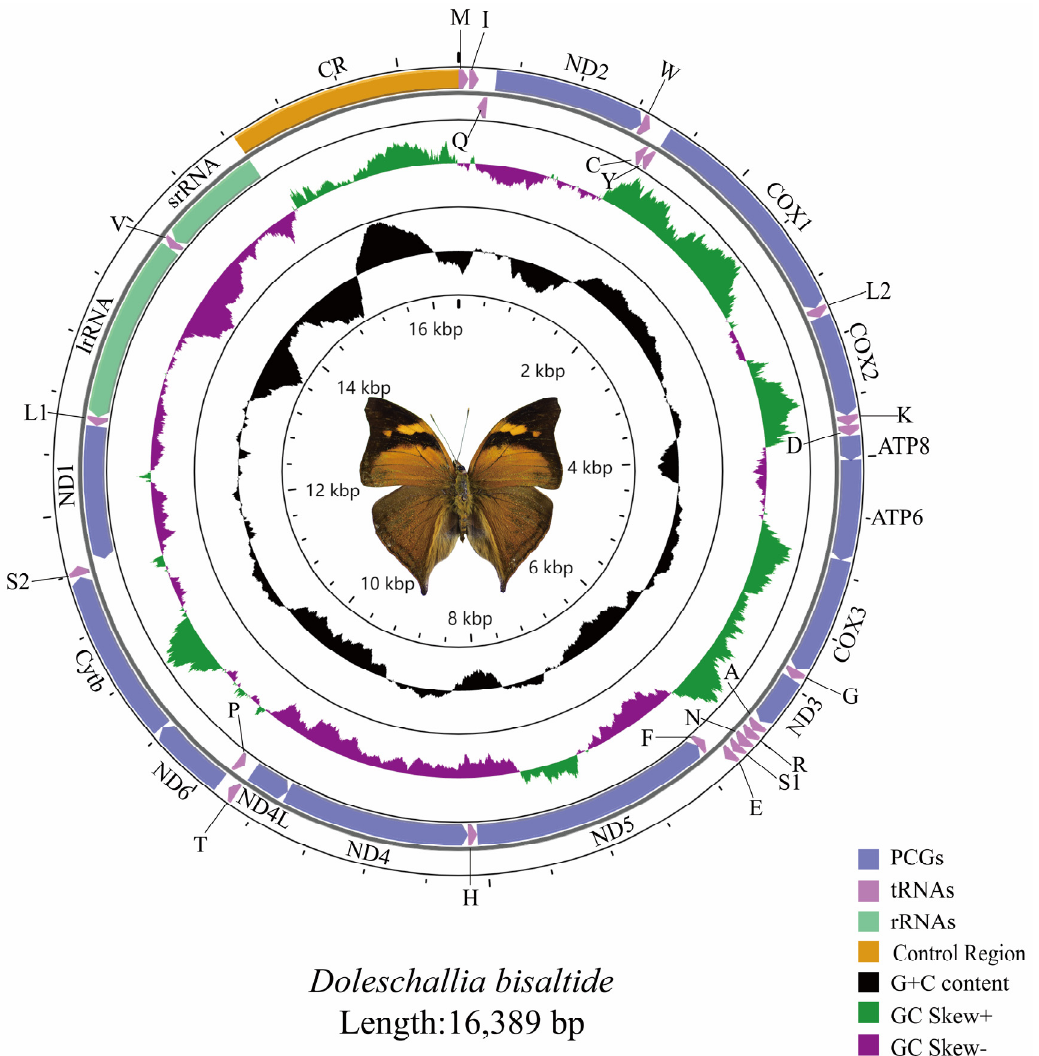
Figure 1. The mitogenome of Doleschallia bisaltide